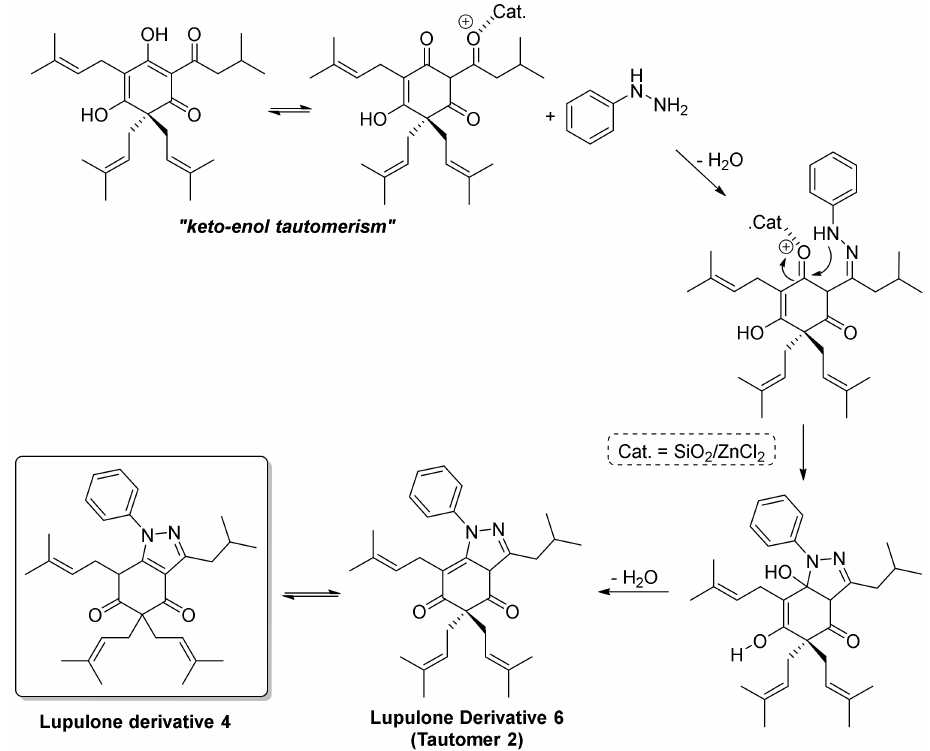
Figure 4. A plausible mechanism to obtain the lupulone derivative 4